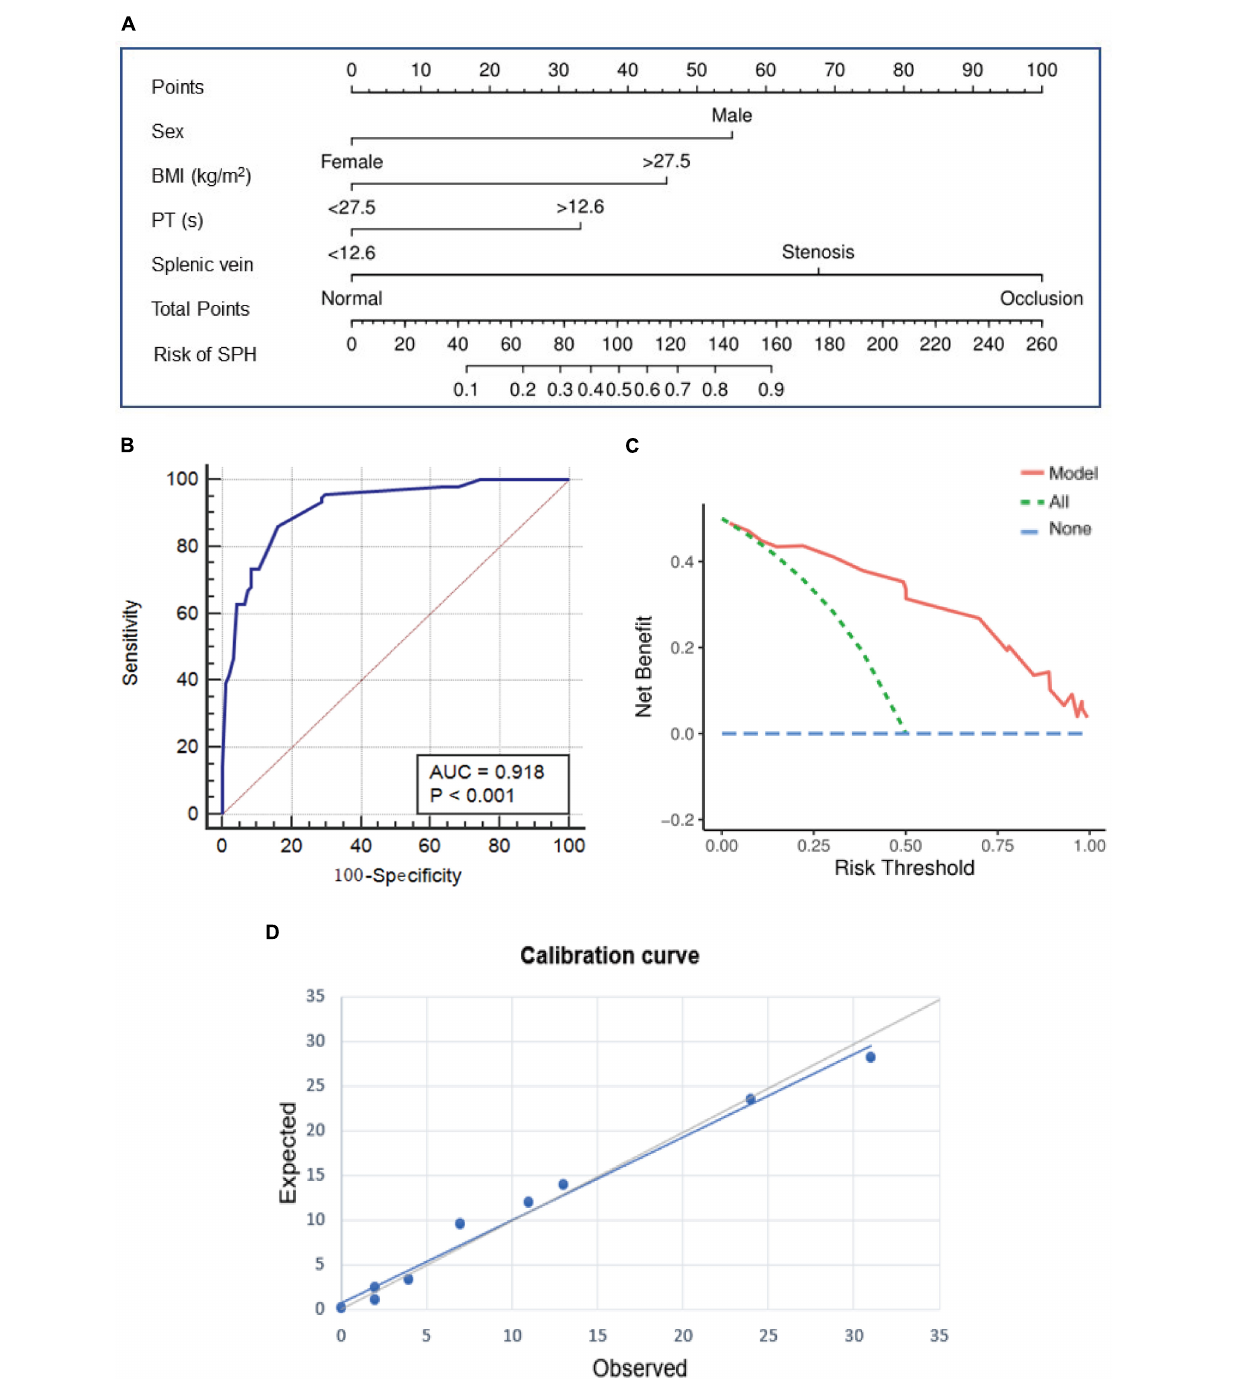
FIGURE 4 | The prediction nomogram and its performance for SPH. (A) Nomogram based on multivariate Logistic regression analysis is developed for the prediction of SPH. ROC curve (B) decision curve analysis (C) , and calibration curve (D) show the good discrimination, calibration, and clinical utility of the novel model. SPH, sinistral portal hypertension; ROC, receiver operating